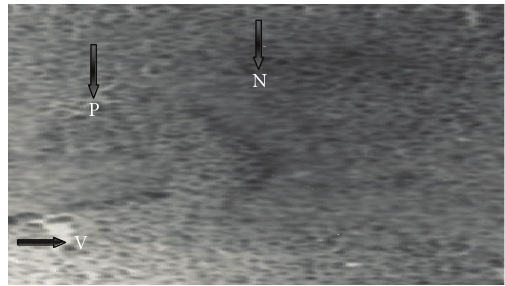
Figure 9: Plate of photomicrograph of liver of Clarias gariepinus after 12 weeks of exposure to 25ppb of gammalin 20 showed mild necrosis (N), swelling of blood vessels, pyknosis (P), and vacuolation (V).